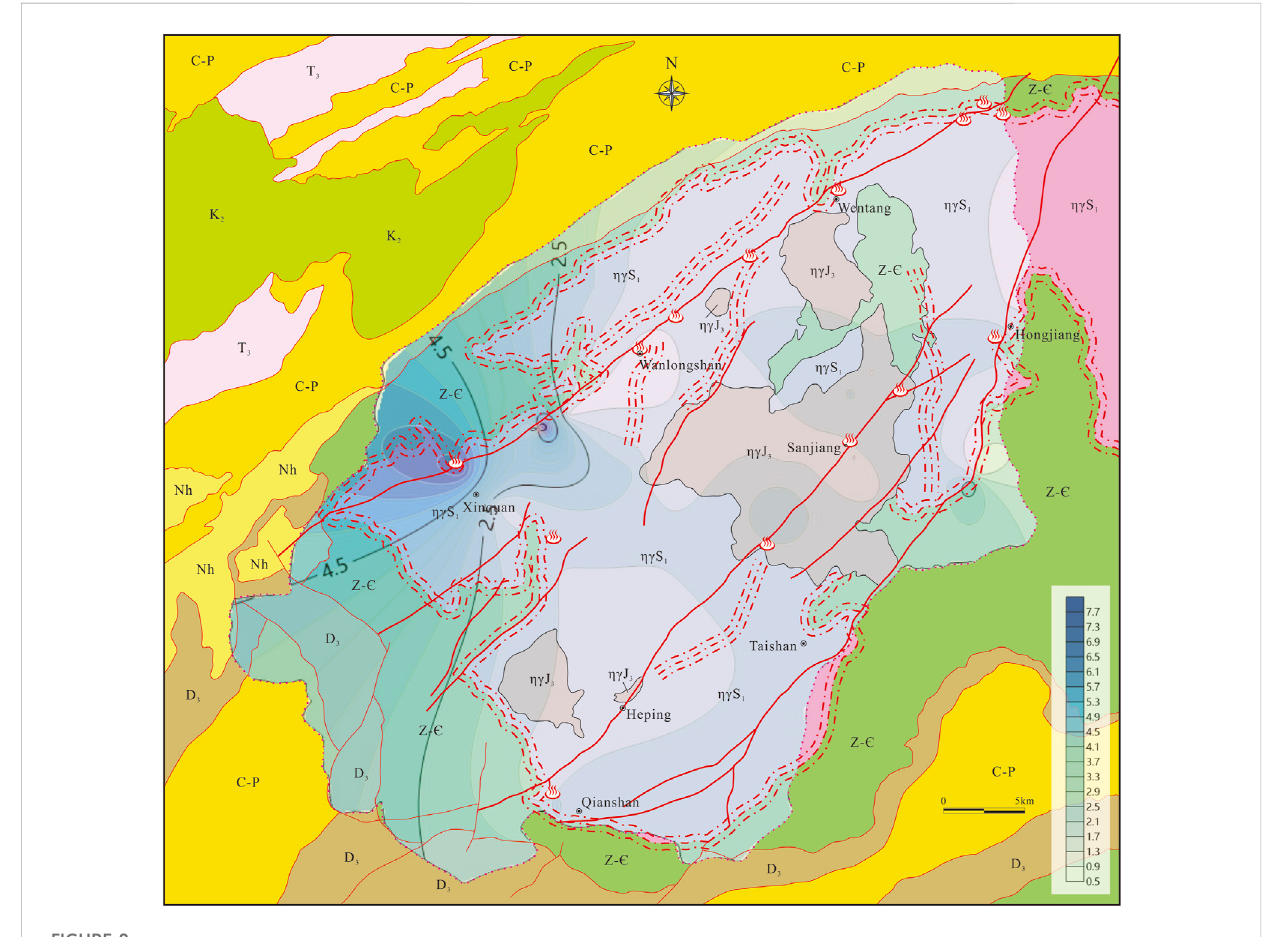
FIGURE 8 Histograms of thermal diffusivities in the Wugongshan